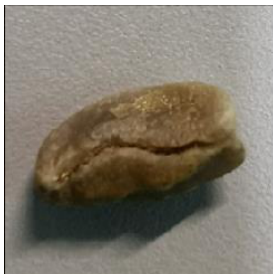
Figure 1. Images captured using a unidirectional light source ( left ) and an omnidirectional light source ( right ).